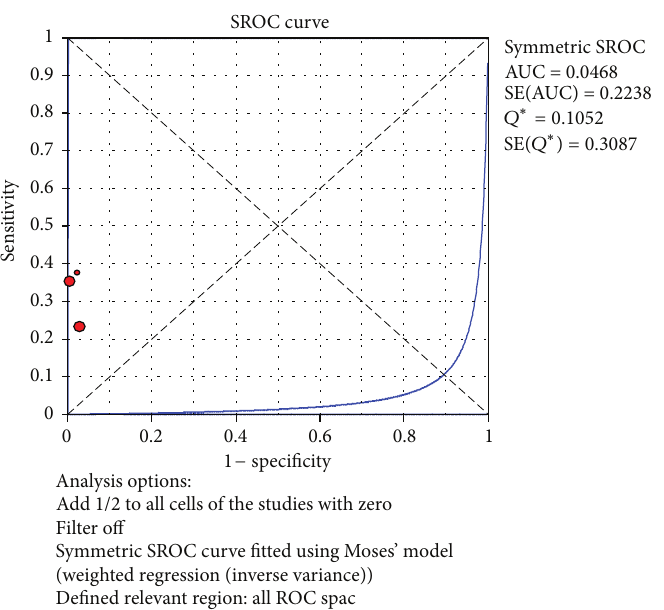
Figure 13: Summary receiver operating characteristic (SROC) curve of the TNF- 𝛼 test for the diagnosis of late-onset neonatal sepsis in the southern hemisphere. Each point represents one study in the SROC